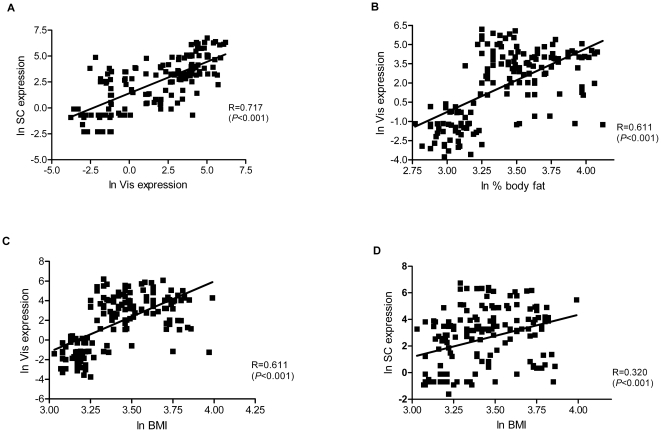
Correlations.A) between visceral (Vis) and subcutaneous (SC) BMPR2 mRNA expression; B) between Vis BMPR2 mRNA expression and % body fat, C) between Vis BMPR2 mRNA expression and BMI, D) between SC BMPR2 mRNA expression and BMI. Data are ln-transformed to achieve normal distribution.